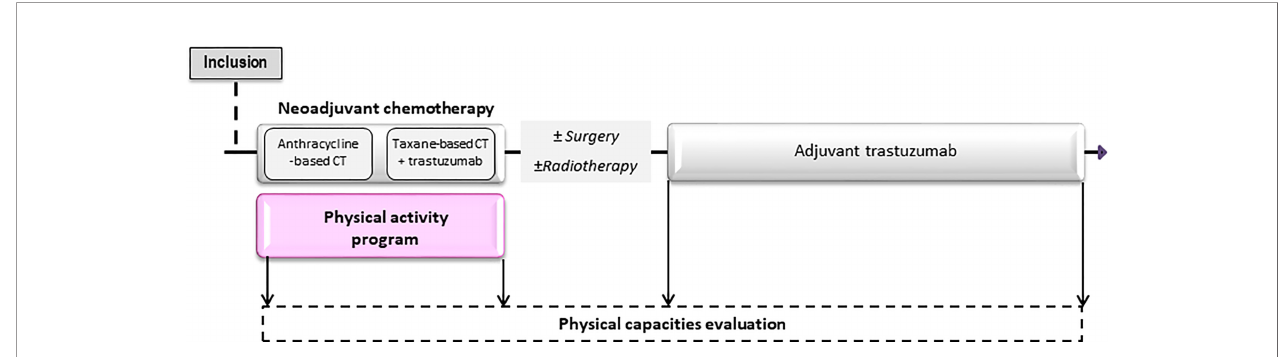
FIGURE 1 | Design of the APACAN2 study. The APA program take place from the beginning to the end of neo-adjuvant chemotherapy. Four follow-up visits are planned during the